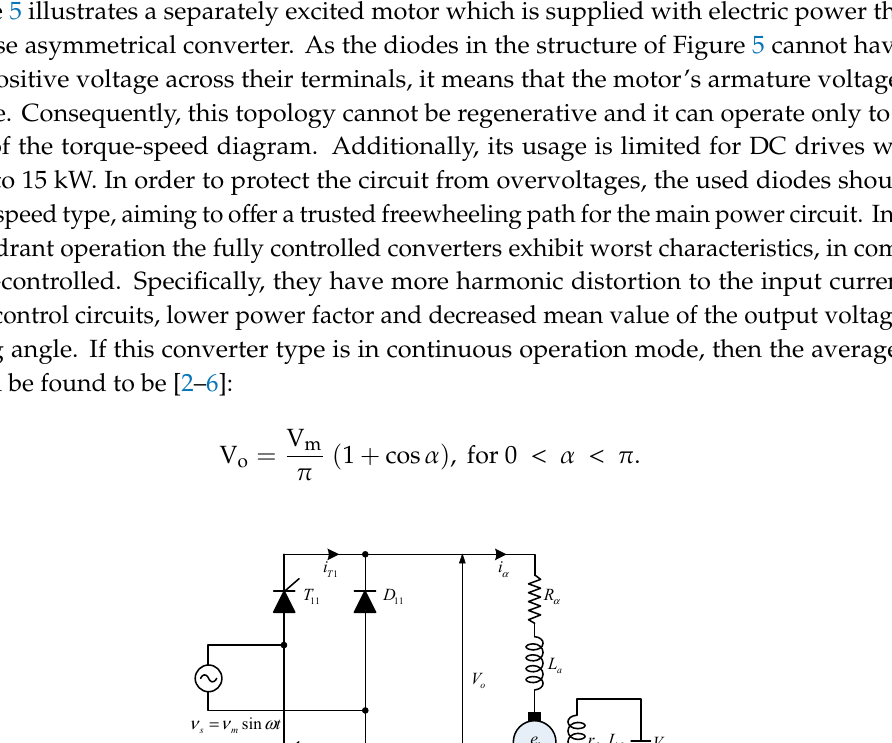
Figure 5. Single-phase half-controlled asymmetrical converter drive.